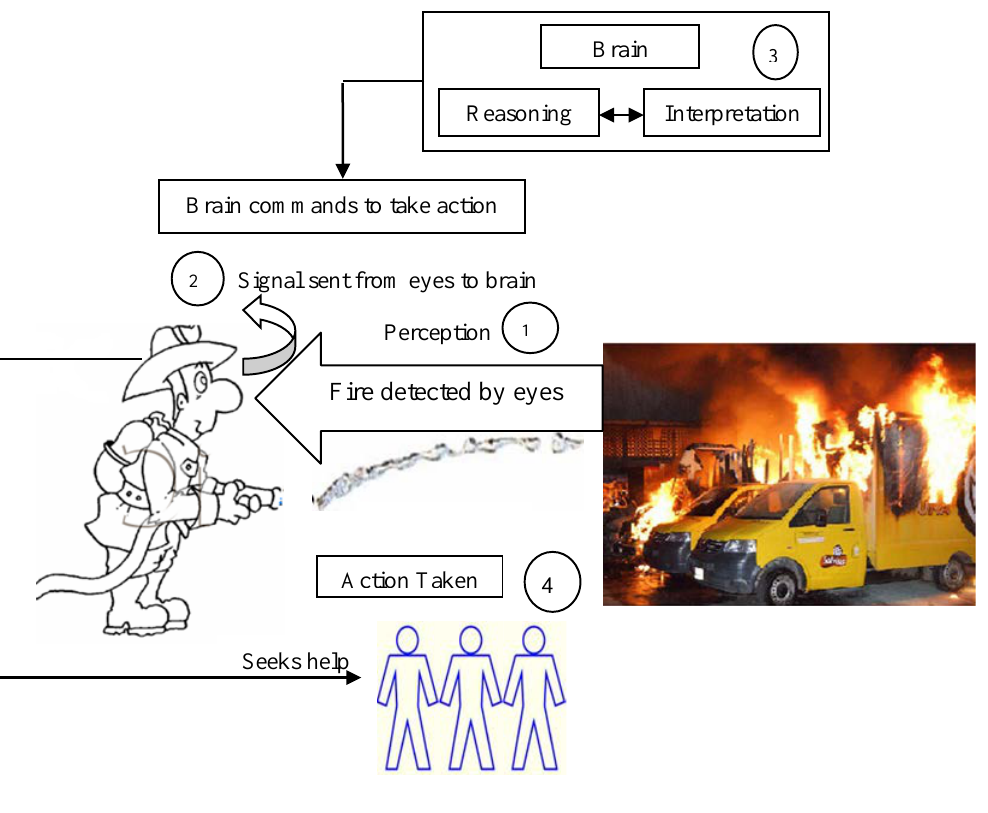
Fig. 1. A cognitive decision making model by human